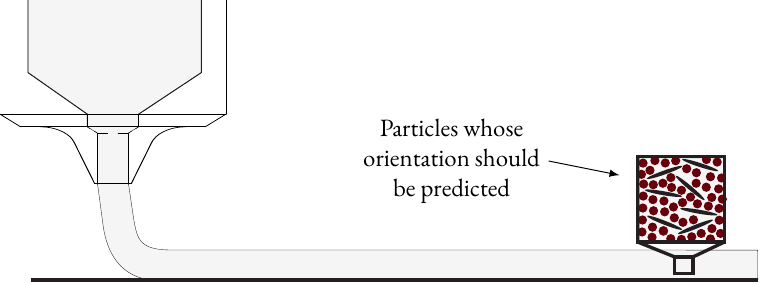
Figure 1. Illustration of an extrusion process with a zoom into the suspension showing round and elongated particles within a homogeneous matrix